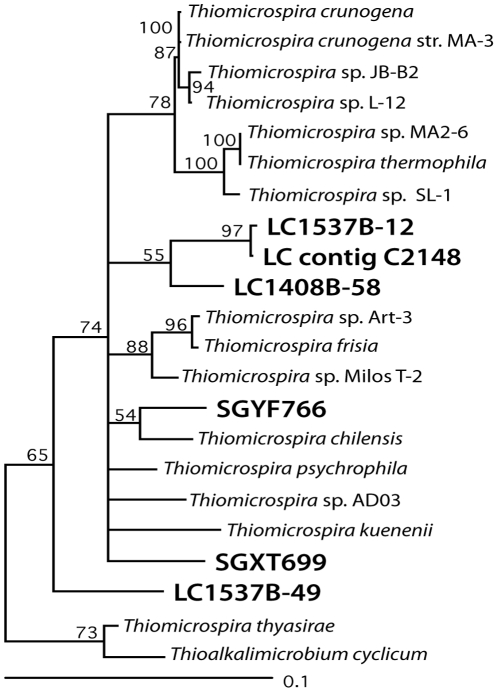
Phylogenetic tree of 16S rRNA sequences from Thiomicrospira cultivated isolates and clones collected from Lost City chimneys.Sequences with 100% identity to the V6 hypervariable region of clone LC1537B-12 and contig C2148 were found to be most abundant in a carbonate chimney aged 34 yrs venting fluids with a maximum temperature of 88°C [6]. Contig C2148 is 9 kb in length, has 42%GC, and has 8.7x coverage. The tree was constructed with Tree-Puzzle 5.2 [32] from 1278 characters aligned with MUSCLE [33]. Quartet puzzling support values are shown; nodes with less than 50% support are collapsed. Genbank accession numbers for each sequence from top to bottom: AF064545, AF069959, AF013972, AF064544, L40811, AB166731, AF013971, DQ270608, ACQI01002148, DQ270607, AF013973, AF013974, AJ237758, FJ792484, AF013975, AJ404732, AY575776, AF013978, FJ792098, DQ270609, AF016046, AF329082.